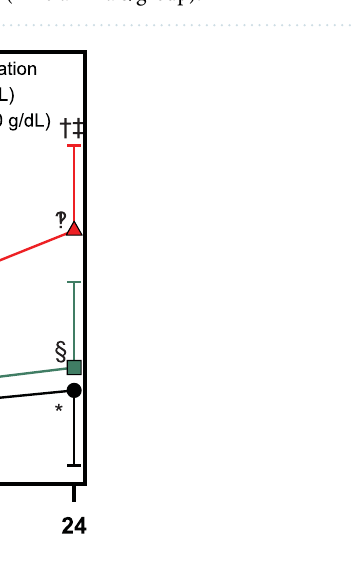
Figure 3. Changes in microcirculatory hemodynamics and wall shear stress following LPS induced endotoxemia. ( a ) Arteriole diameter, ( b ) blood velocity, ( c ) blood flow, and ( d ) arteriole wall shear stress with no resuscitation, infusion of HSA, or infusion of PolyHSA. The shaded blue region on the plots indicates the period of fluid resuscitation with PolyHSA or HSA. Data are presented as mean and SD. † P < 0.05 between the PolyHSA and no resuscitation groups at the same time point. ‡ P < 0.05 between the PolyHSA and HSA groups at the same time point. Symbols next to data points indicate a significant (P < 0.05) difference at that time point compared to baseline conditions for (*) no resuscitation and (§) HSA (n = 6 animals/group).